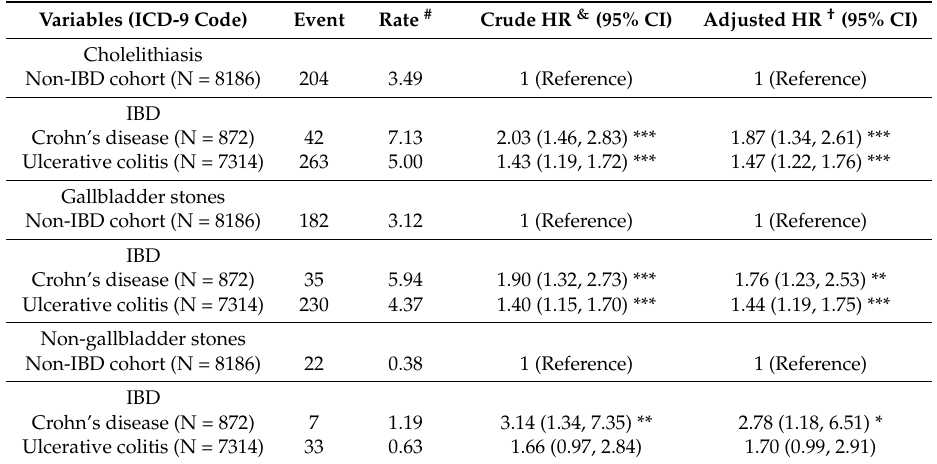
Table 4. Cox model-measured incidence of cholelithiasis and hazard ratios for patients with and without inflammatory bowel